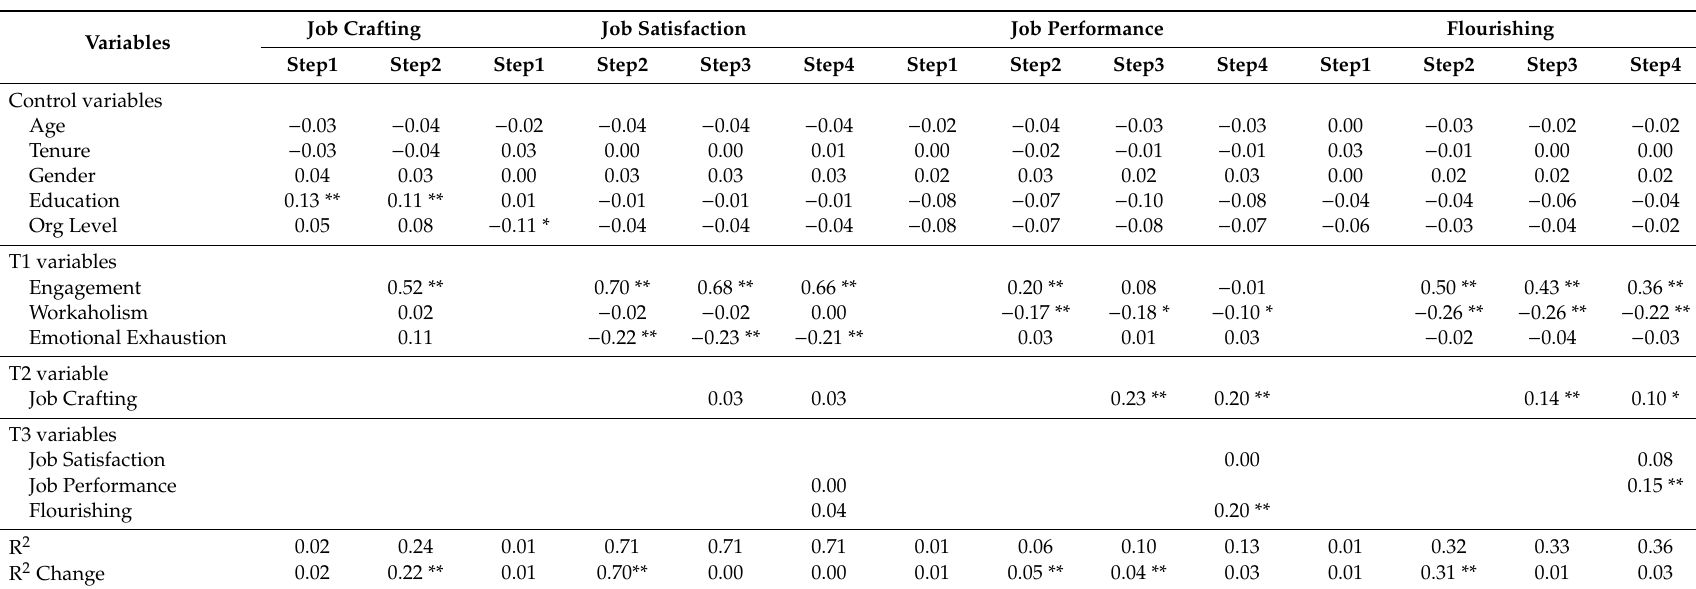
Table 2. Multiple regression